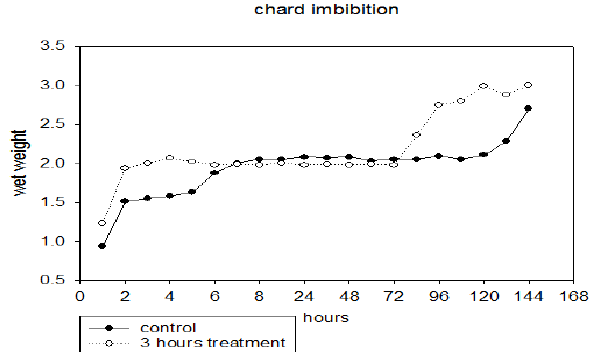
Fig.3. Imbibition curve of control and the highest significant treatment of chard seeds